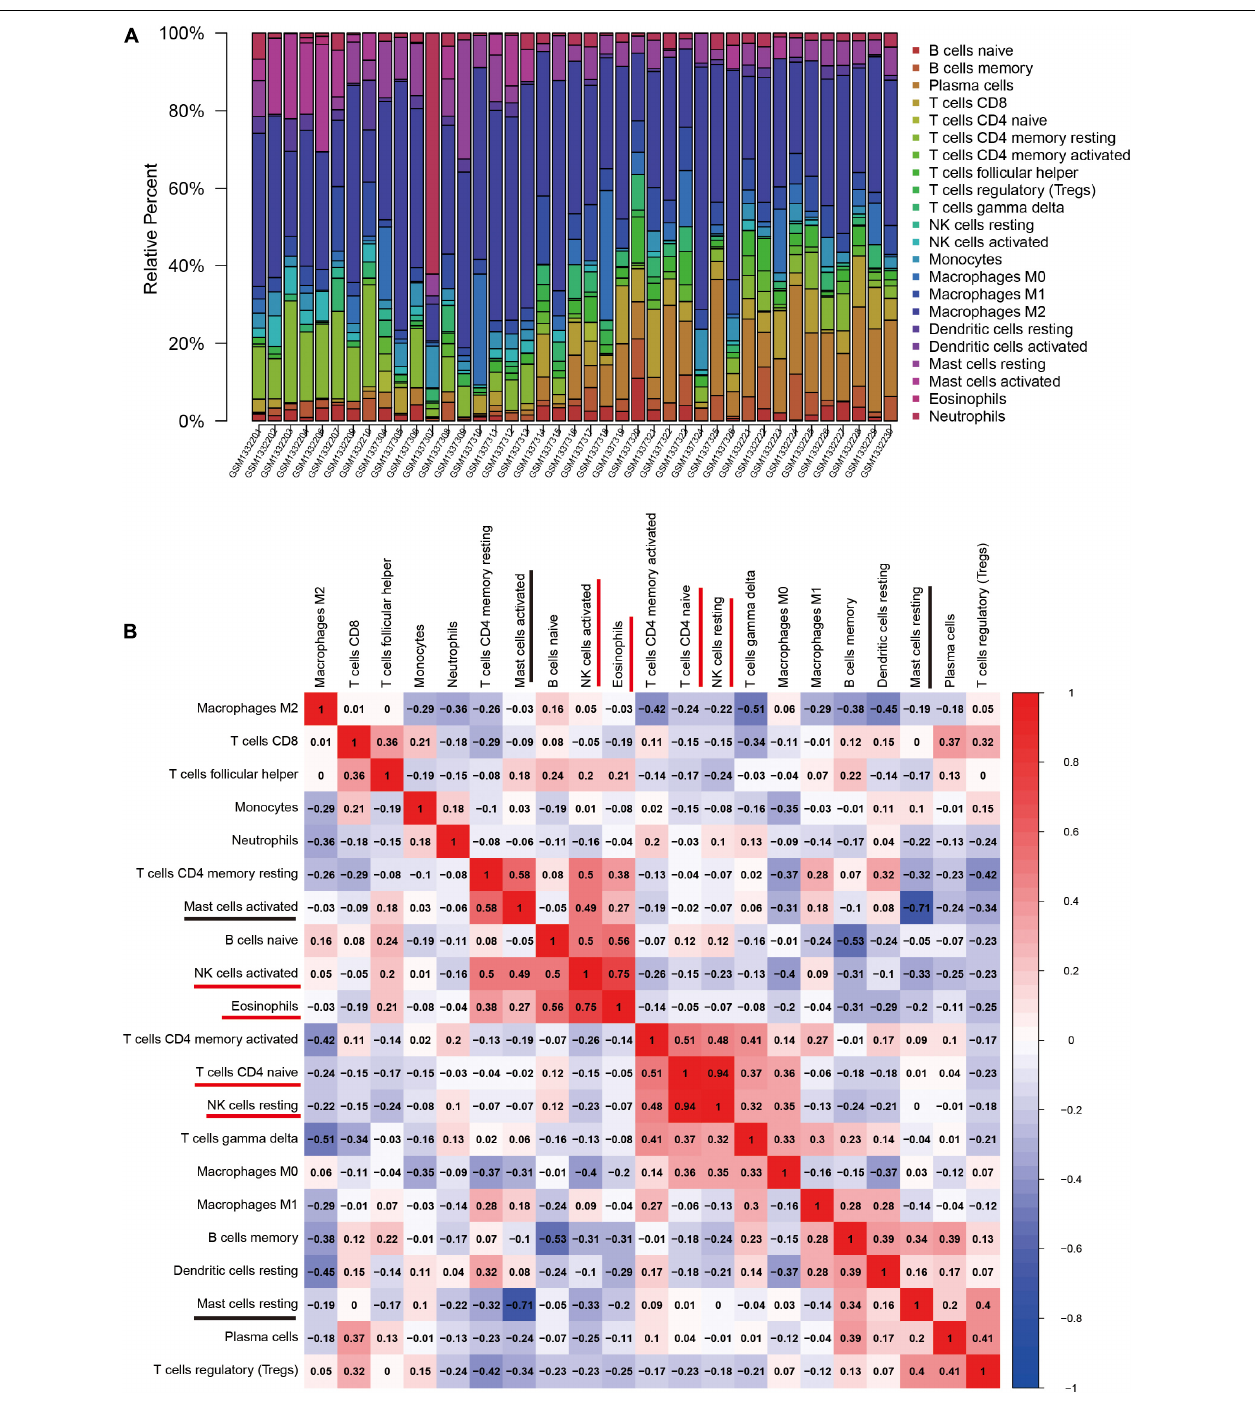
FIGURE 4 | The landscape and correlation heatmap of immune infiltration in synovial membrane samples between the normal and osteoarthritis (OA) groups. (A) Relative distribution of 22 immune cells in all samples. (B) Correlation heatmap of immune cells in all samples. Red squares indicate positive correlation and blue squares indicate negative correlation; the deeper colored squares indicate stronger